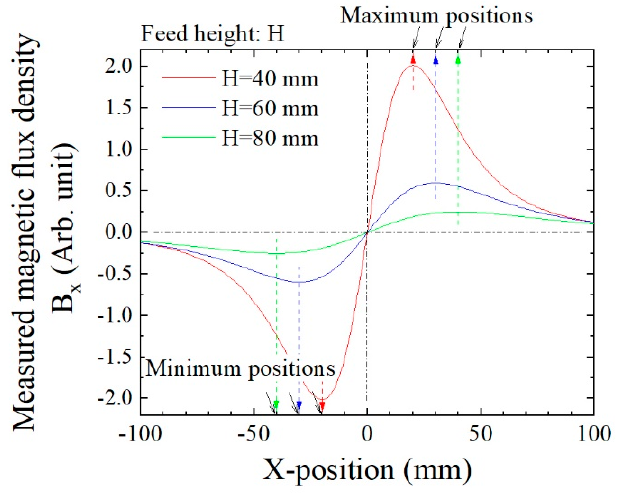
Figure 15. Schematic explanation of extreme points obtained by numerical simulation.